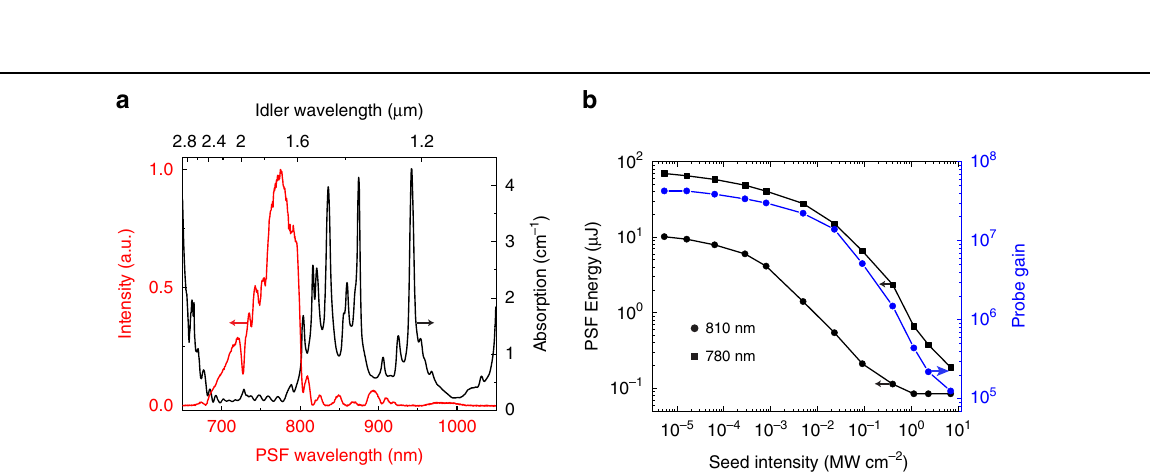
Fig. 5 Suppression of PSF noise by QPCPA. a Measured full PSF spectrum (red) and idler absorption spectrum of the Sm:YCOB crystal (black). b Evolution of the PSF energy (black squares and circles) and probed small-signal gain (blue circles). As shown in Fig. 2c, the PSF energies within a 0.4-cm aperture are detected after two 10-nm bandpass fi lters of 810 nm (circles) and 780 nm